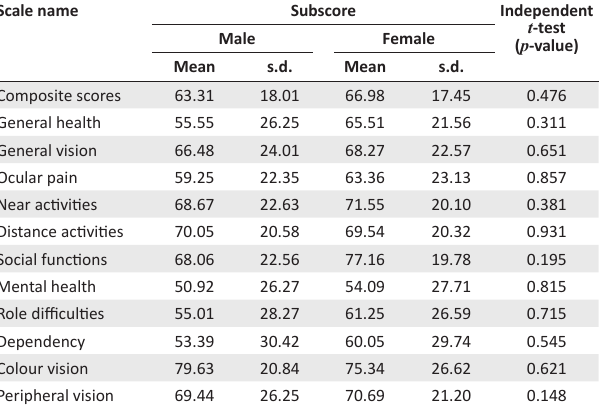
TABLE 5: The mean and standard deviation (s.d.) of subscores of the items on the National Eye Institute Quality of Life Questionnaire-25 for participants with refractive error and visual impairment based on gender.